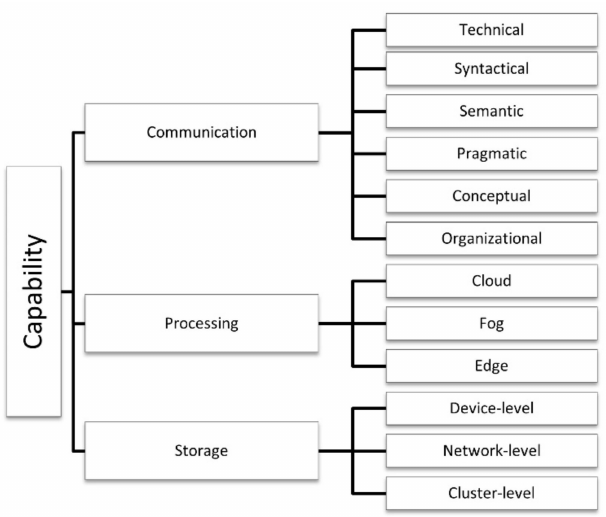
Figure 6. IoE Taxonomy: capability category, its dimensions, and